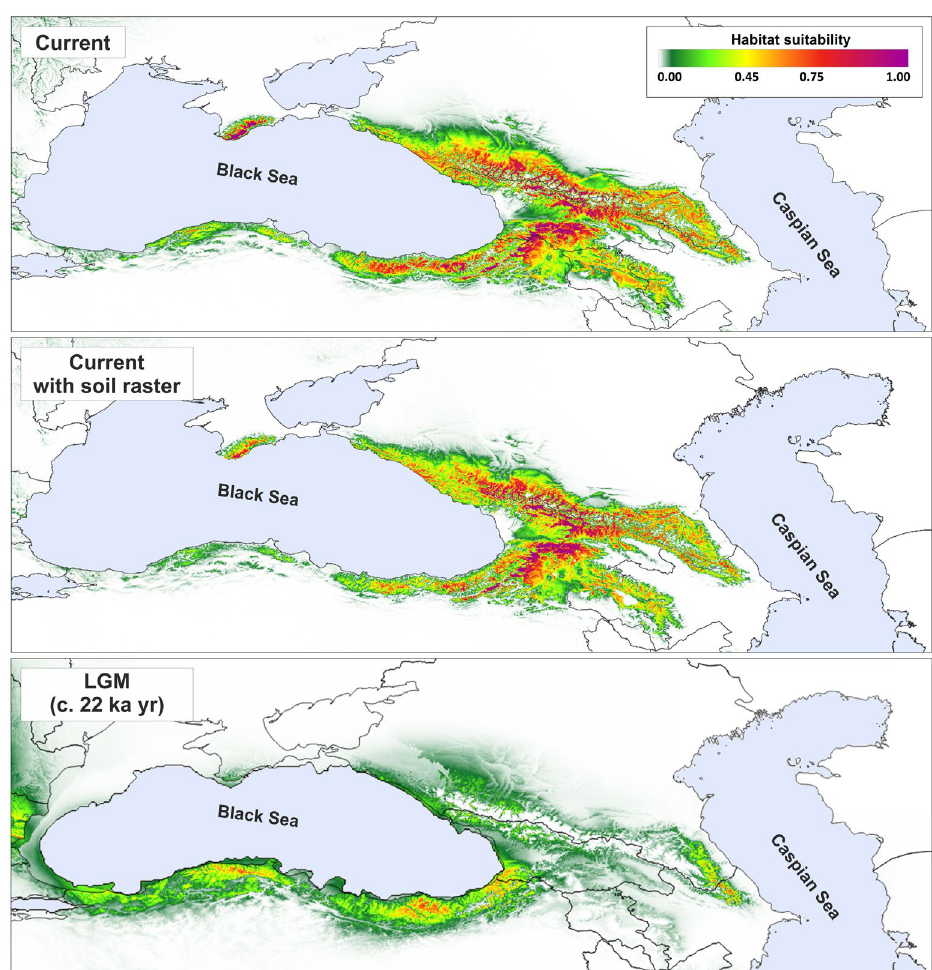
Figure 5. Theoretical range of Scots pine in the Caucasus and Anatolia in different periods estimated with MaxEnt based on raster data from CHELSA database. Current—current theoretical range; Current with soil raster—current theoretical range with soil preferences; LGM—theoretical range during last glacial maximum. Figure generated with QGIS 3.16 (https:// qgis. org/ en/